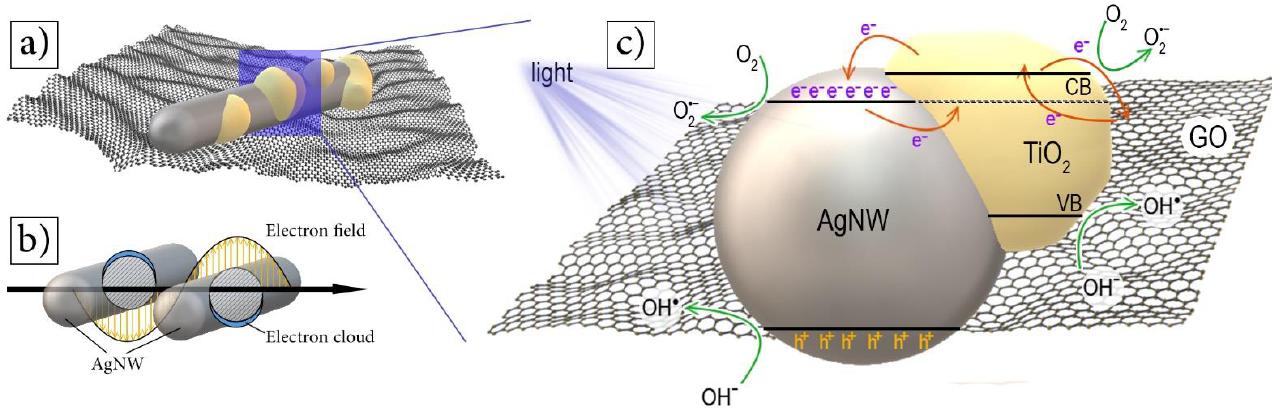
Figure 11. Schematic diagrams of ( a ) AgNW/TiO 2 /GO nanocomposite structure, ( b ) localized SPR of AgNWs when irradiated with visible or UV light, and ( c ) photocatalytic mechanism of AgNW/TiO 2 /GO nanocomposites.